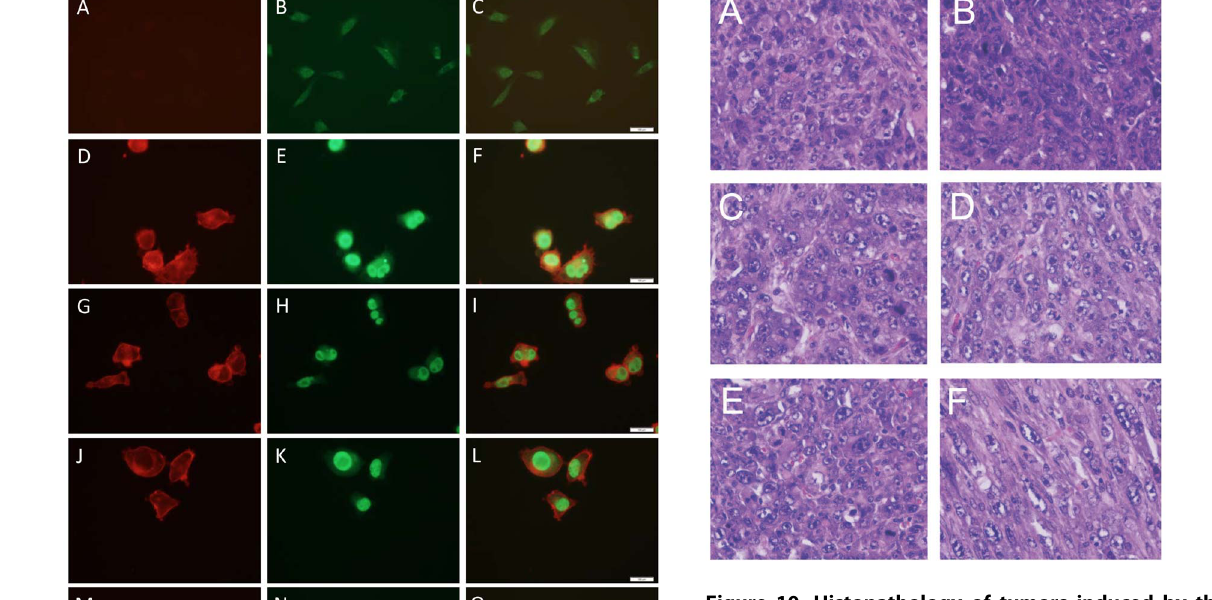
Figure 10. Histopathology of tumors induced by the ras / myc plasmid. Tumors induced by circular pMSV-T24-H- ras /MSV-c- myc (panels A and B ), and tumors induced by linear pMSV-T24-H- ras /MSV- c- myc (panels C , D , E , and F ). Tumors in panels A to E were undifferentiated sarcomas, while the tumor shown in panel F had the appearance of a differentiated